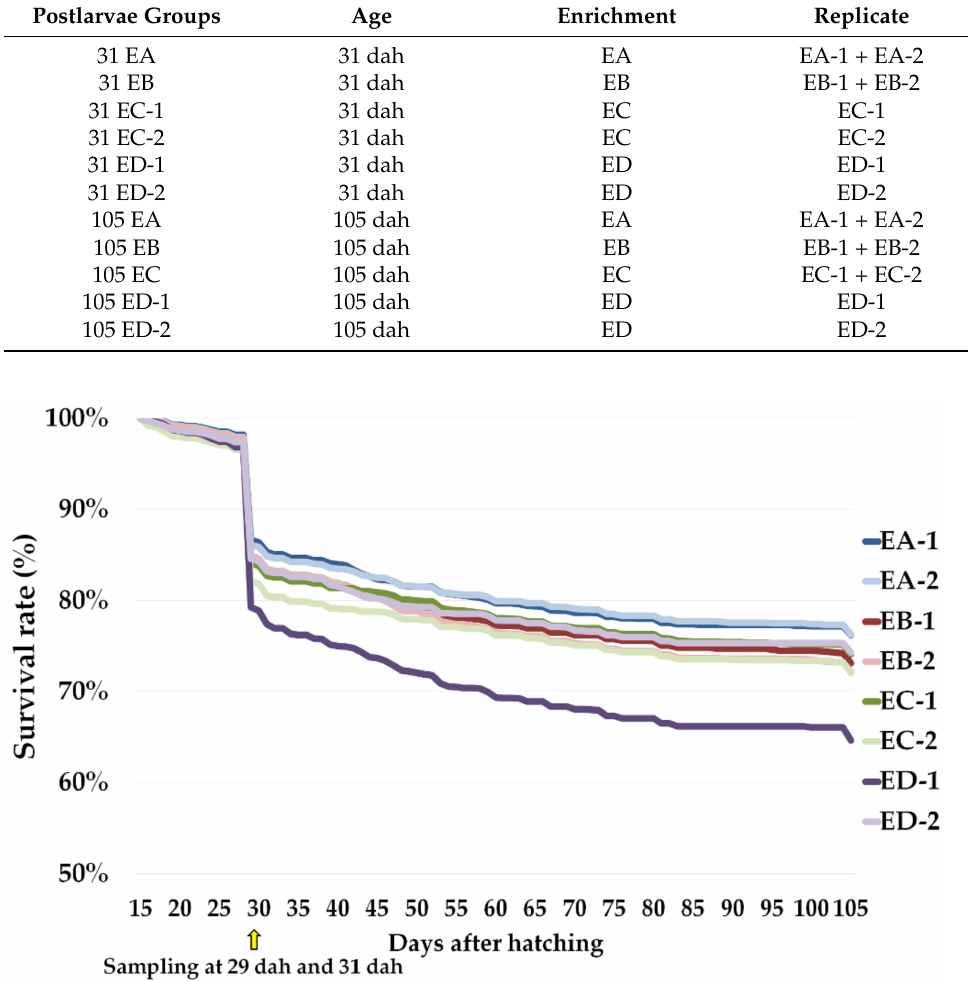
Figure 1. Survival rate (%) for each replicate (EA-1, EA-2, EB-1, EB-2, EC-1, EC-2, ED-1, ED-2) from 15 to 105 days after